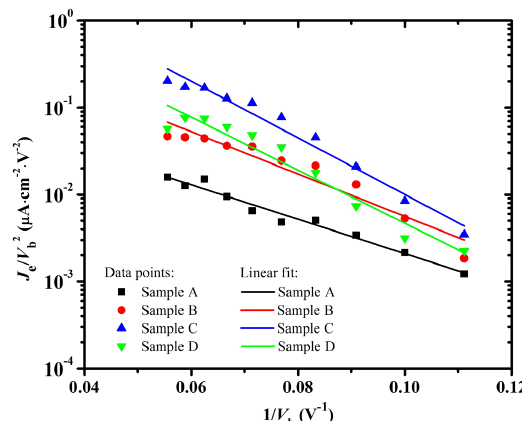
and emission d Figure 8. Fowler-Nordheim plots of four SRSO-film cathodes